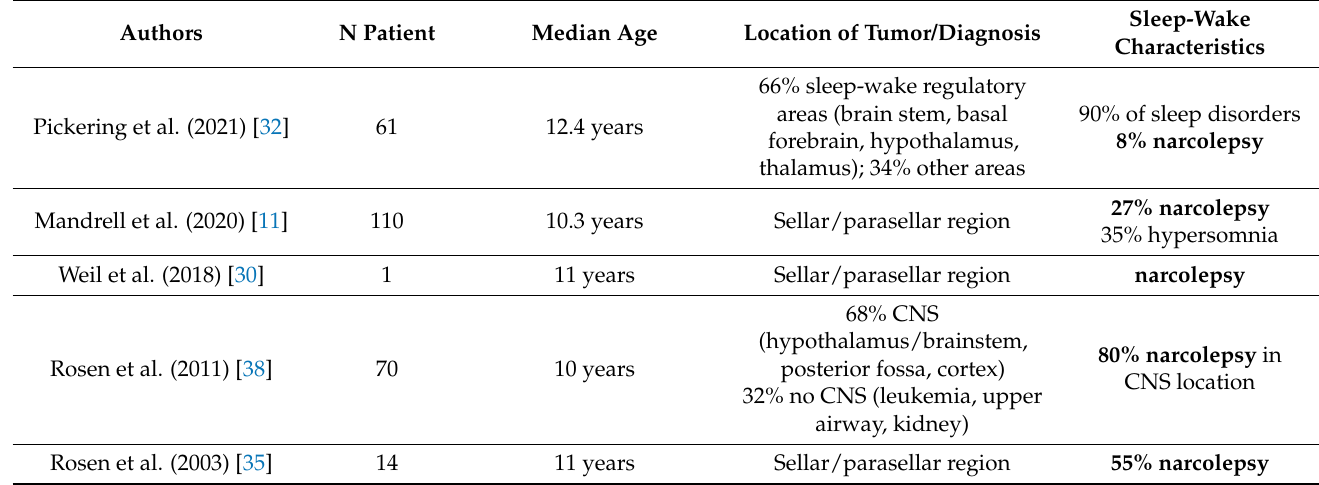
Table 1. Review of pediatric series of secondary